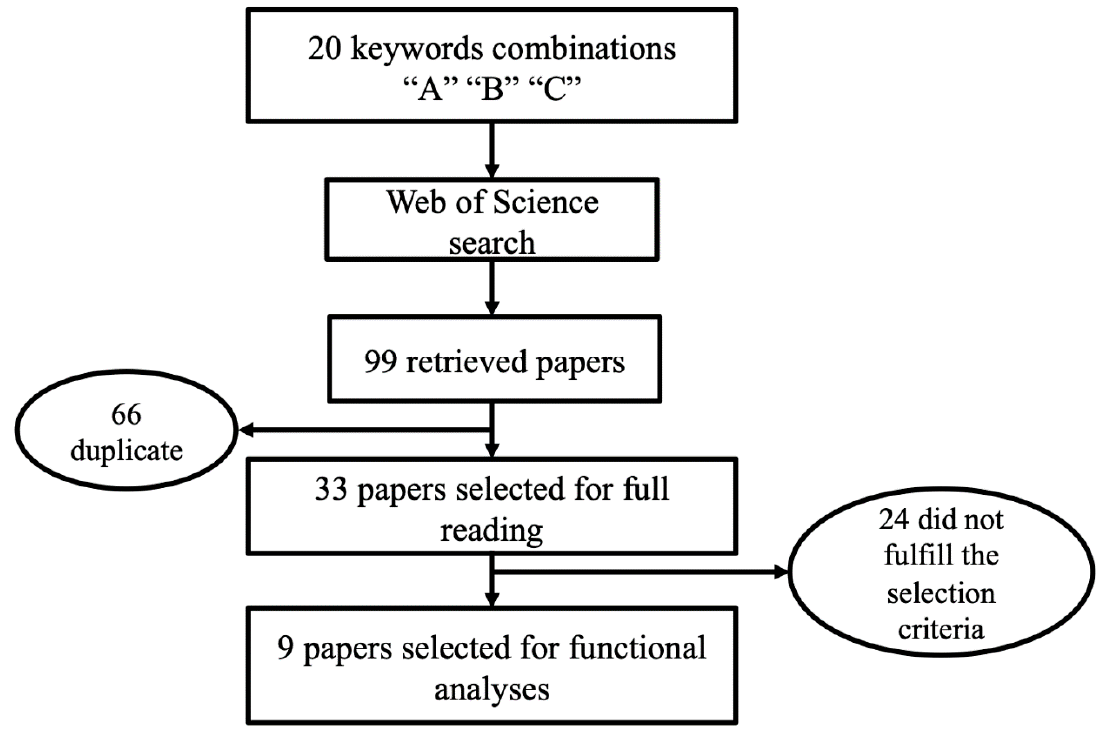
Figure 1. Flow chart displaying the pipeline used to select articles based on specific criteria to the systematic review.